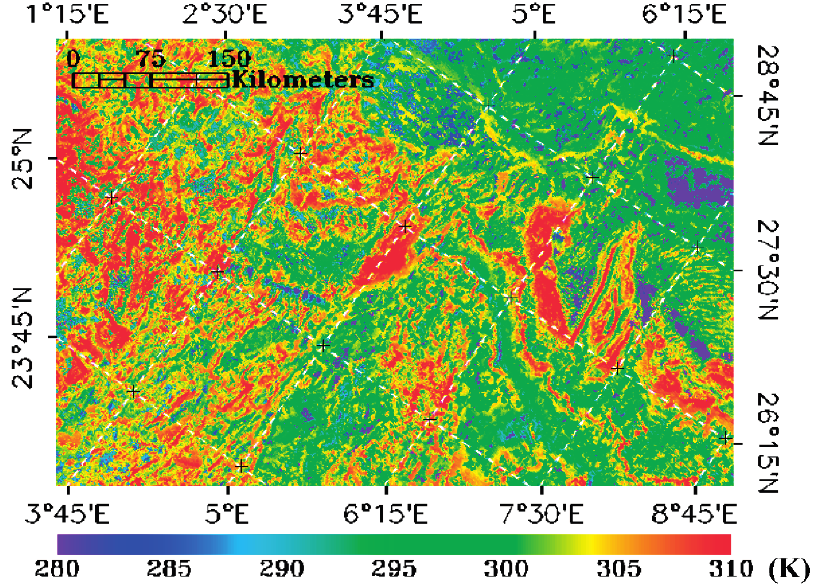
Figure 10. Map of LST estimated from FY-3A VIRR satellite data at the observation time of 10:30 UTC, 5 January